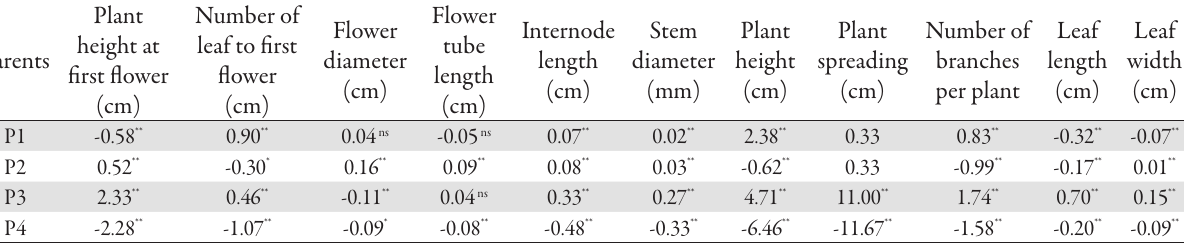
Tab. 3. Estimates of general combining ability (GCA) effects of the parents for plant height at first flower, number of leaf to first flower, flower diameter, flower tube length, internode length, stem diameter, plant height, plant spreading, number of branches per plant, leaf length and width in